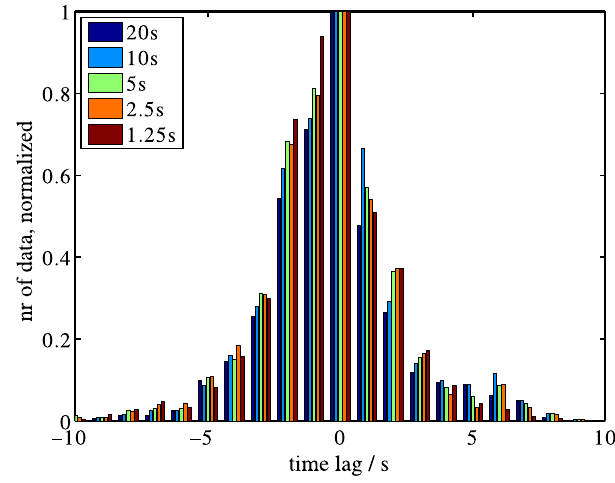
Fig. 9. Measured traveltime anomalies δT for all paths in the North Fig. 8. Measured traveltime anomalies δT for all paths in the North American data set, in all five frequency bands (distinguished by American data set, in all five frequency bands (distinguished by colour). Only data whose fit exceeds CC max > 0 . 8 are plotted. The color). Only data whose fit exceeds CC max > 0 . 7 are plotted. The histograms are normalized so that at δT = 0, each bar has value histograms are normalized so that at δT = 0 , each bar has value 1.